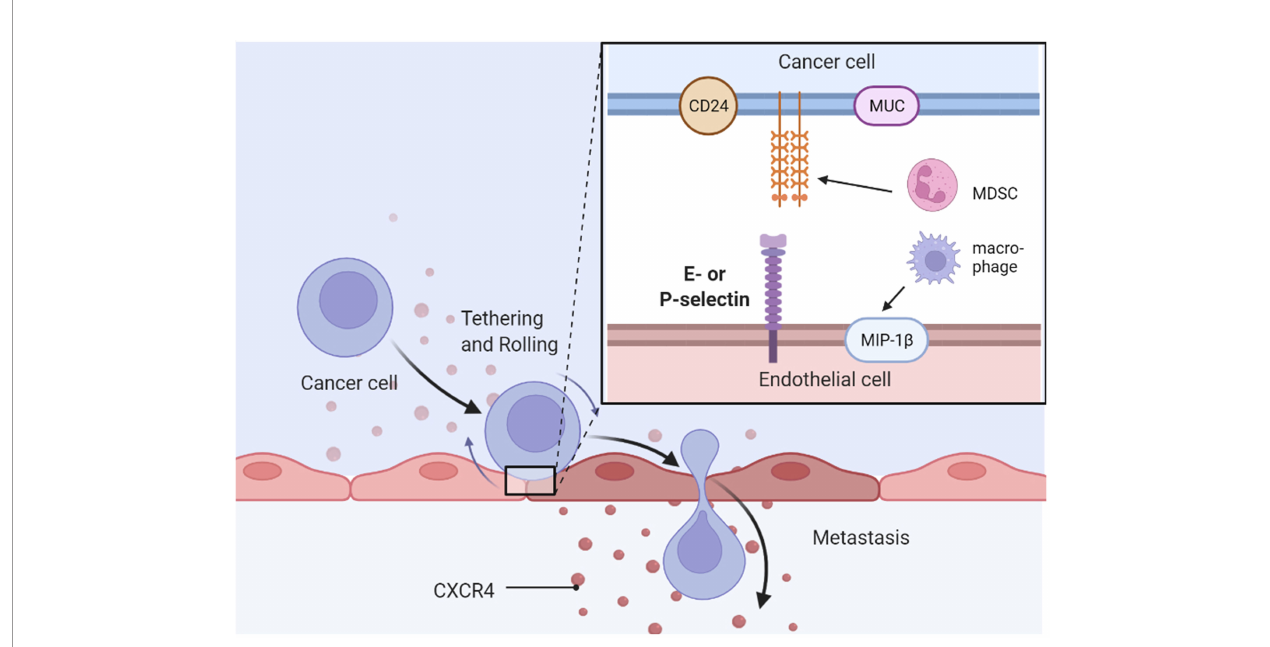
FIGURE 4 | Selectins mediates metastasis of cancer cells. MDSC, myeloid-derived suppressor